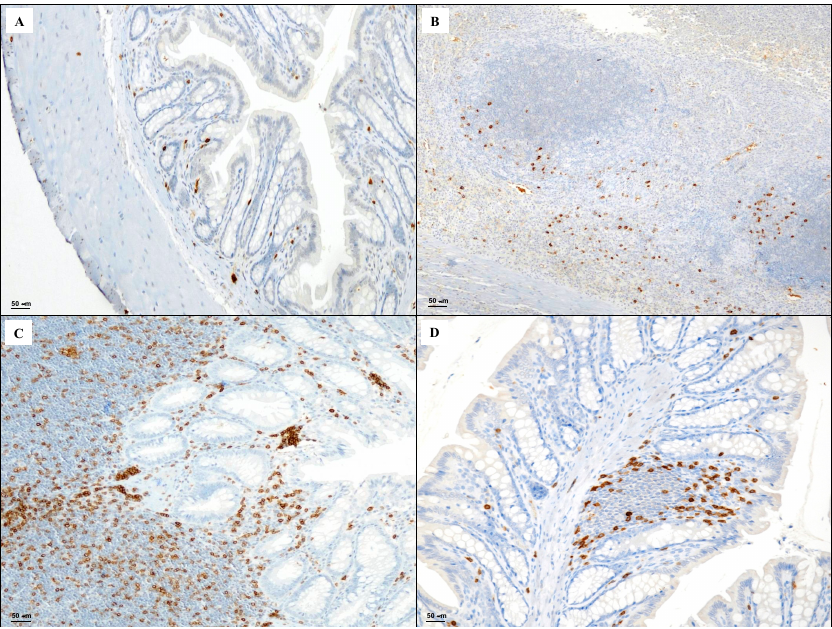
Figure 4. Representative CD3 immunostaining (original magnification × 20) of tissues derived from control ( A ), DNBS + Drug vehicle ( B ), DNBS + Poly ( C ), and DNBS + Poly + HA ( D ).